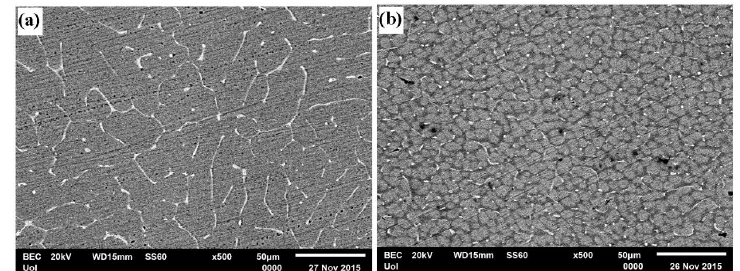
Figure 3. Microstructures of CP-Al produced by ( a ) stir casting of Al1050-H14 and ( b ) vacuum arc remelting of Al1050-H14.